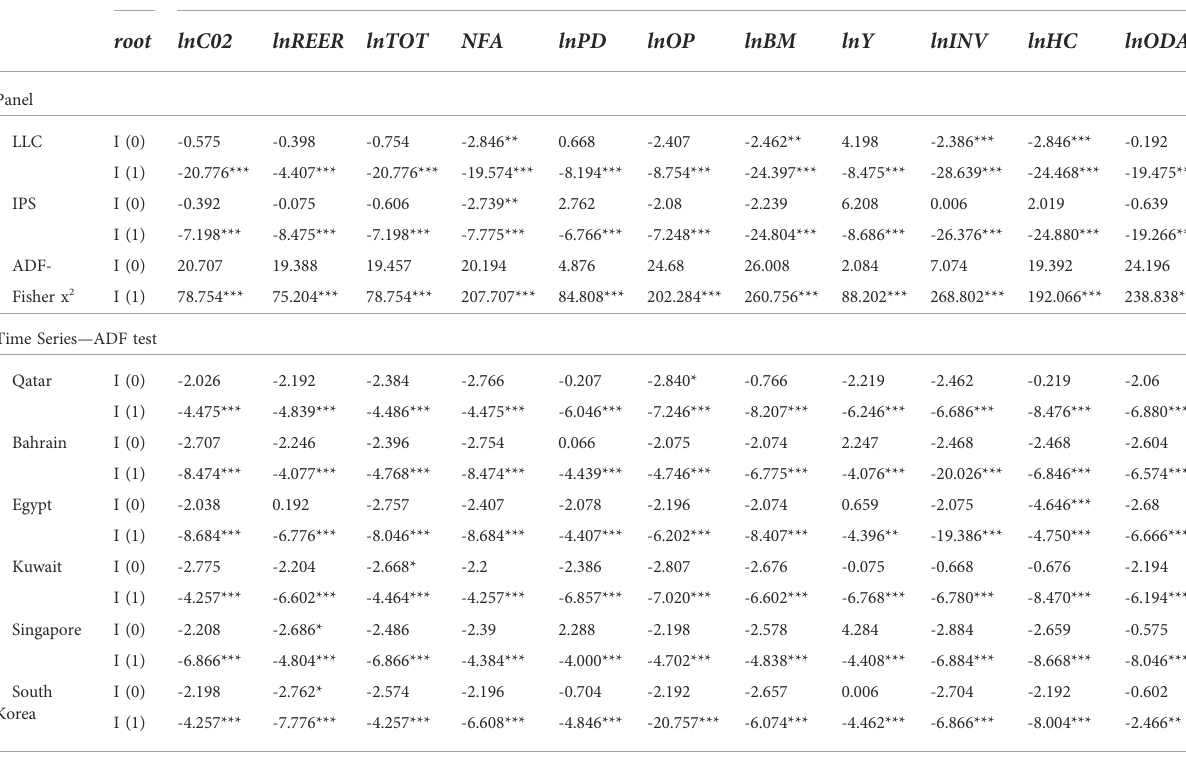
TABLE 2 RER Model Cointegration test results from the Johansen Fisher panel. Hypothesized No. of CE